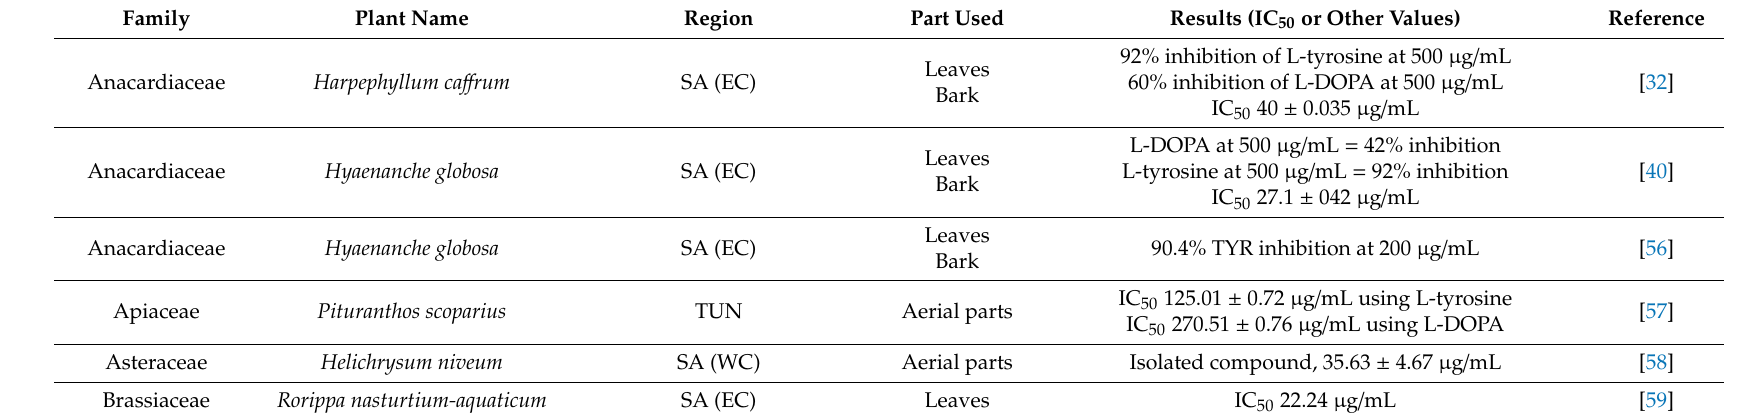
Table 2. Summary of the plant species identified and their tyrosinase